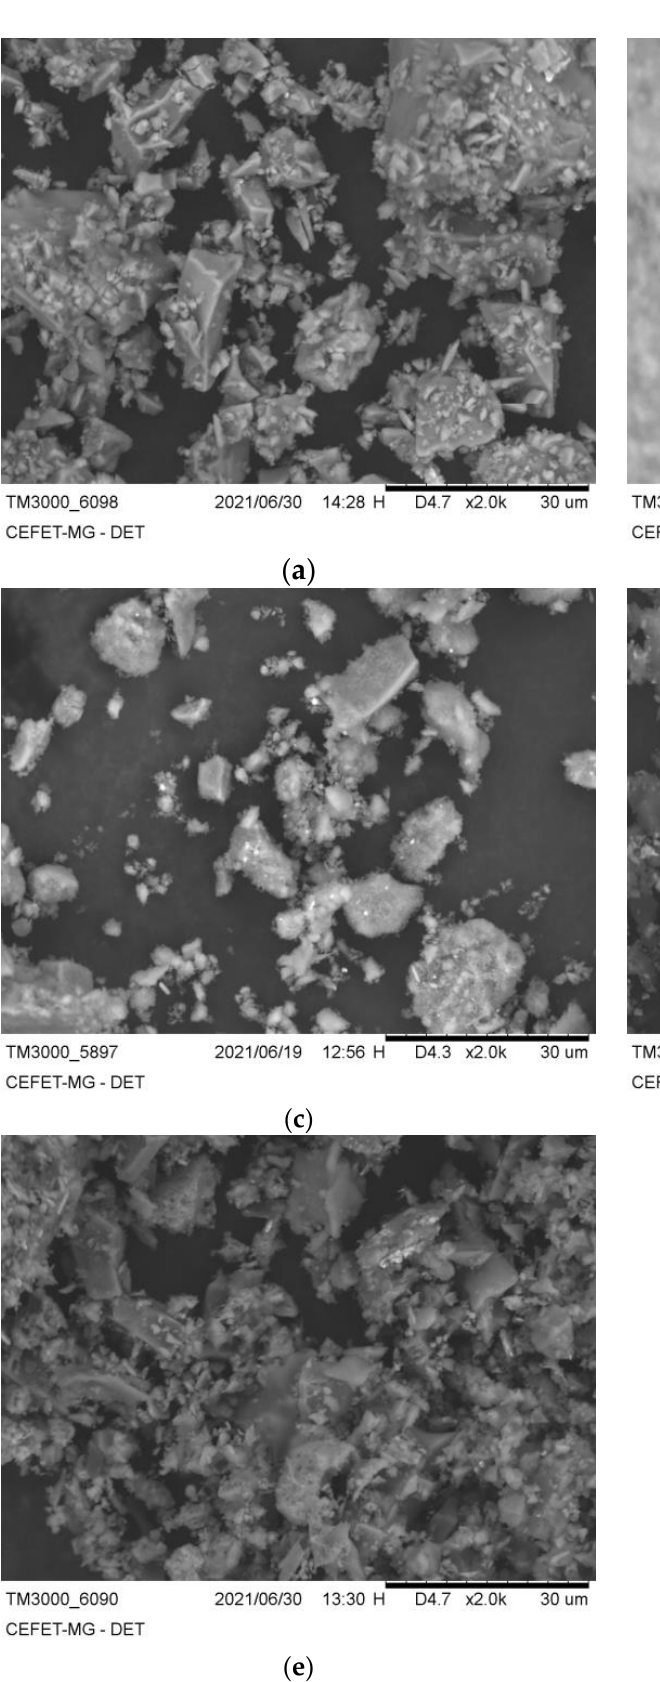
Figure 2. Micrographs of ( a ) BFS, ( b ) SF, ( c ) MK, ( d ) SCBAM, and ( e ) SCBAMH.